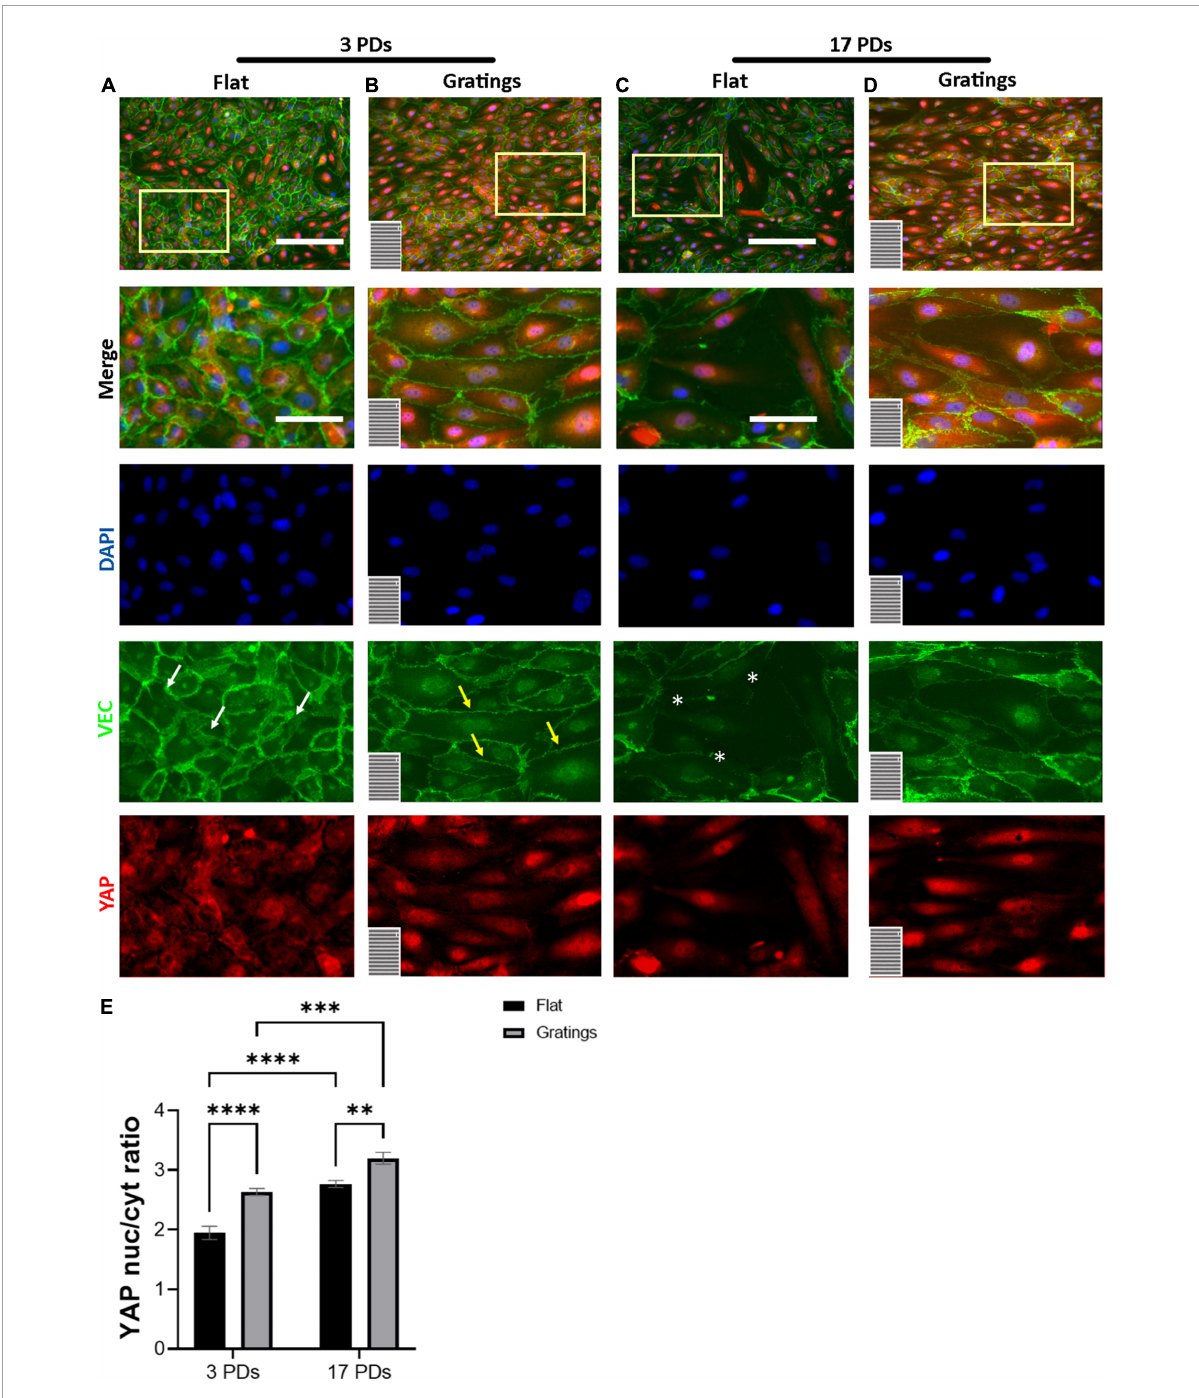
FIGURE5 YAP nuclear translocation after HUVECs culture on gratings. (A–D) Immunofluorescence analysis of monolayers of HUVECs after 3 or 17 PDs cultured either on a flat surface or on a micro-structured surface with gratings. Cells were stained with an antibody against YAP (red), DAPI (blue), and VEC (green). The orientation of the gratings is indicated in the lower left corner. Yellow rectangles indicate the zoom-in areas. White arrows indicate zipper-like junctions on flat surface, while yellow arrows linear junctions on a surface with gratings. White asterisks indicate monolayer disruption on the flat surface. Scale bars, 200 µ m; scale bars of zoomed images, 100 µ m. (E) Quantification of YAP nuclear translocation as a ratio of YAP nuclear signal to YAP cytoplasmic signal. Data represent the mean and standard error of the mean 3 donors with more than 1,500 cells per condition. ∗∗ p ≤ 0.01; ∗∗∗ p ≤ 0.001; ∗∗∗∗ p ≤